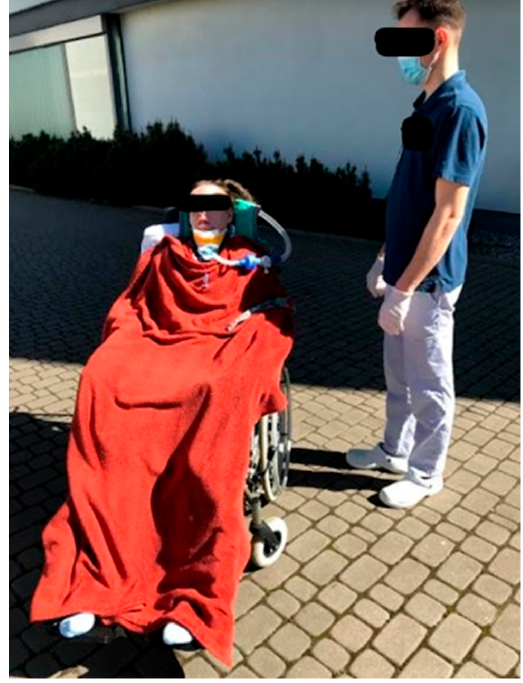
Figure 1. Patient adapted to sitting in a wheelchair.